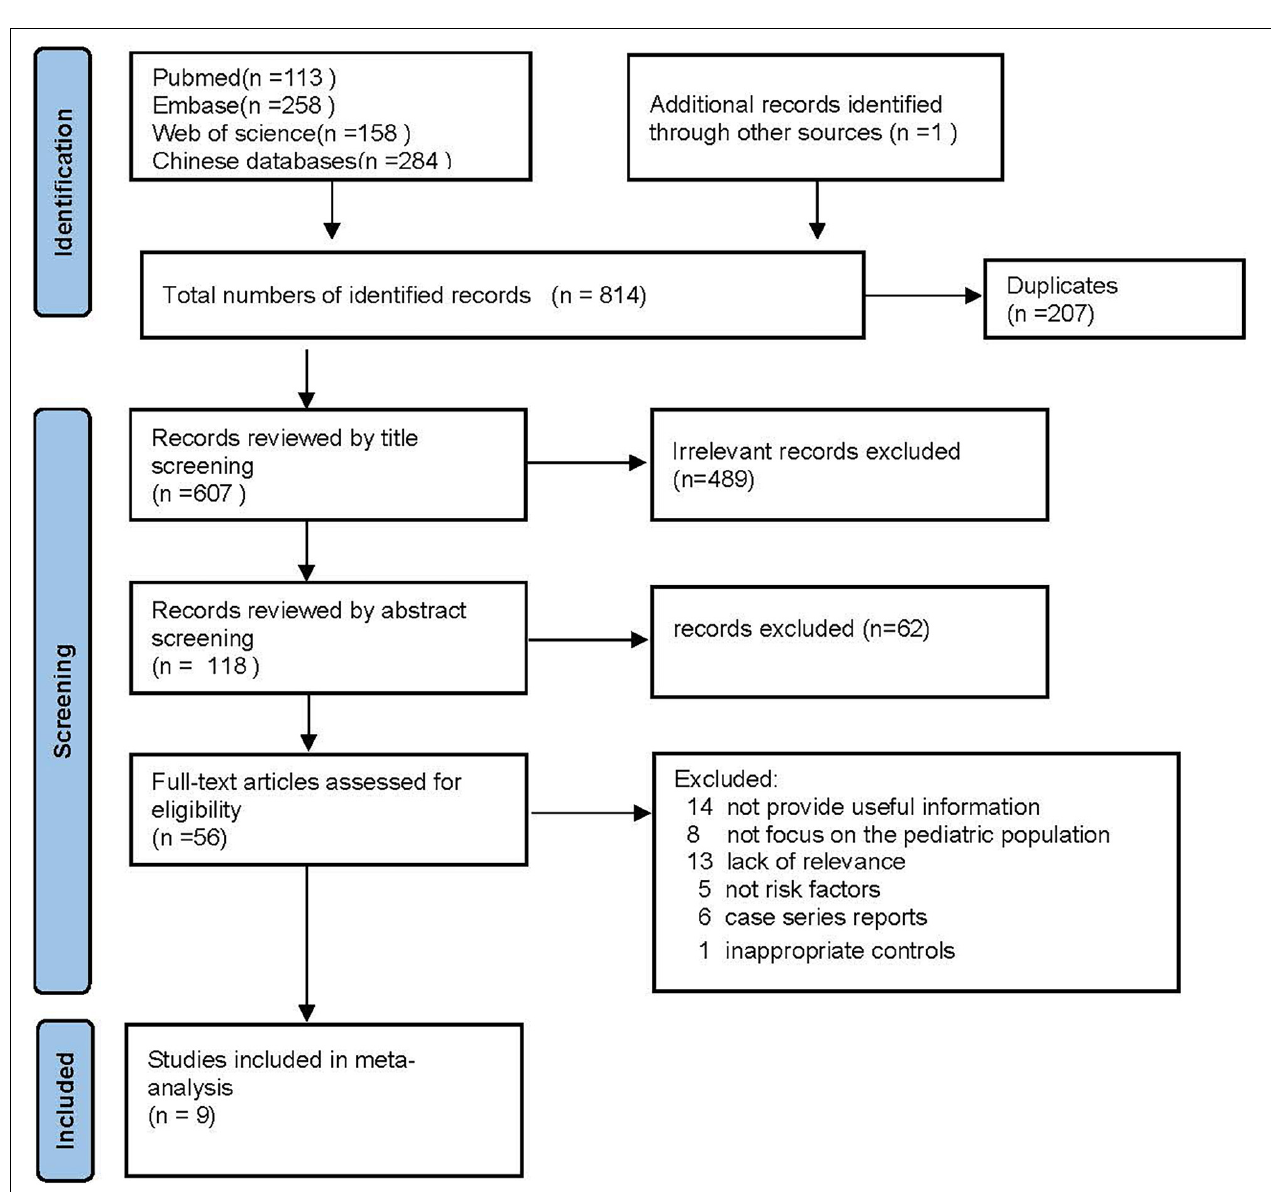
FIGURE 1 | A flow diagram demonstrating the process of inclusion and elimination of